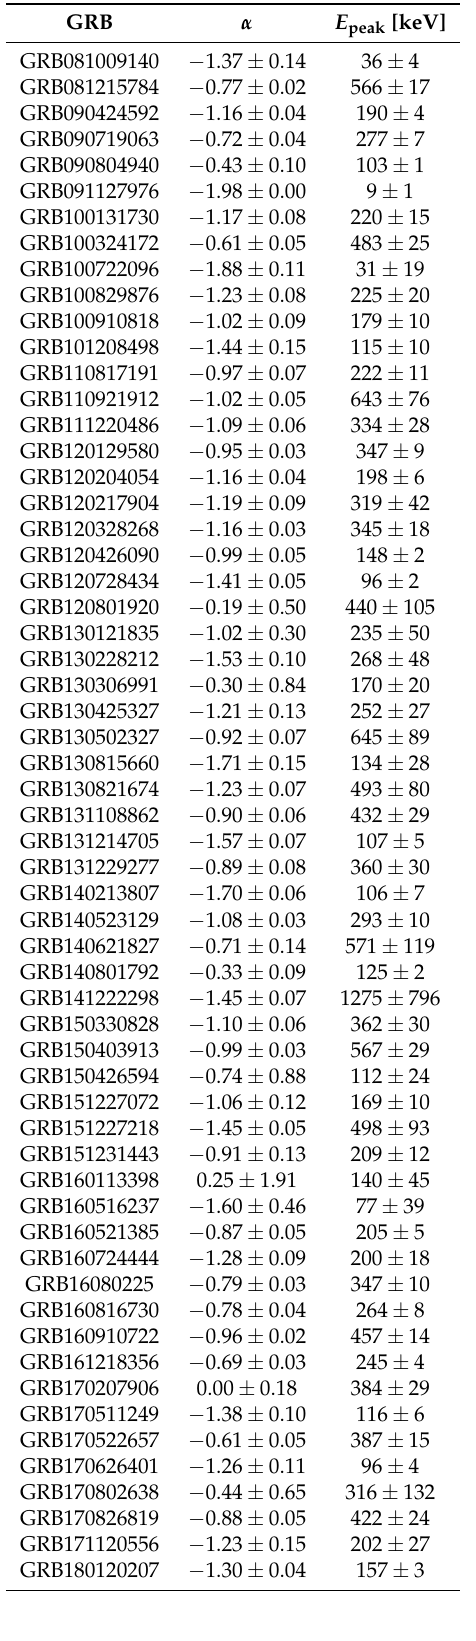
Table 2. Spectral parameters of long